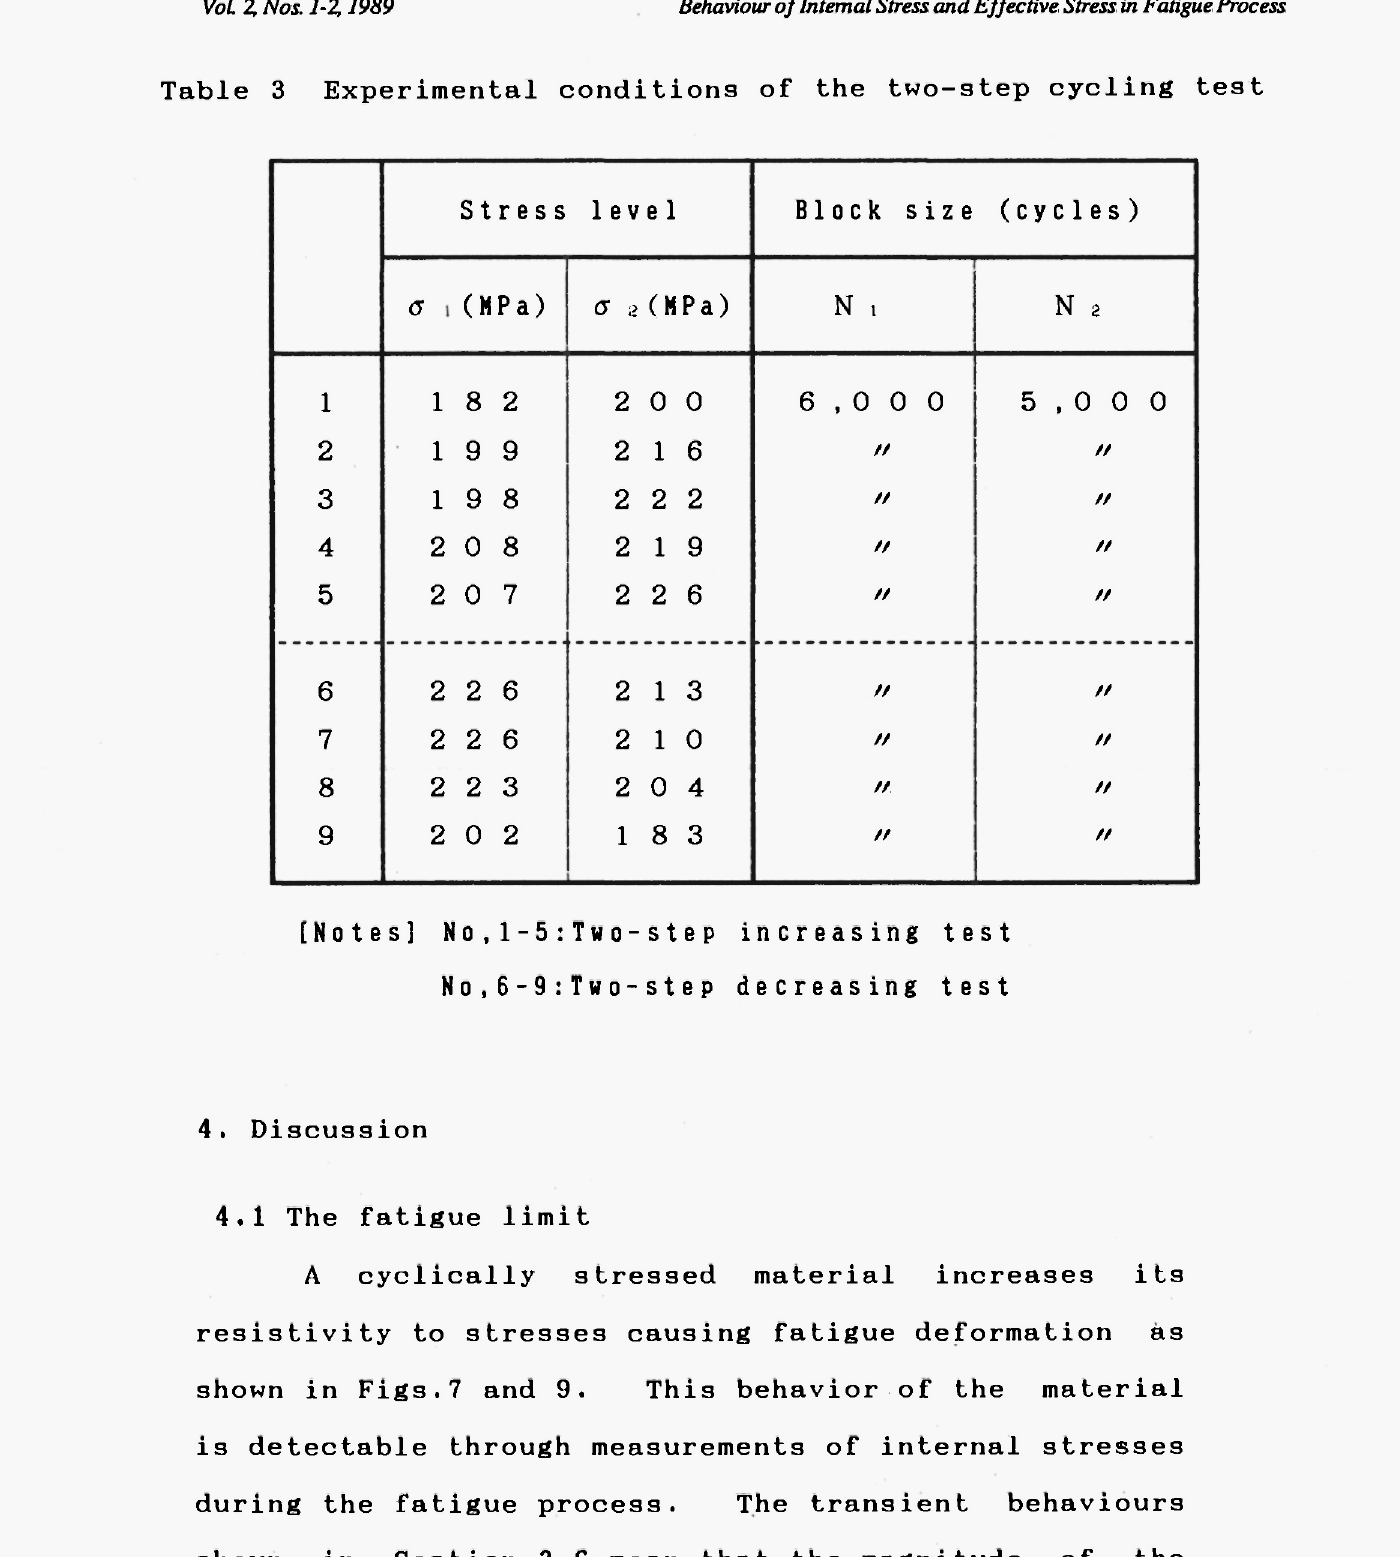
3 Experimental conditions of the two-step cycling test